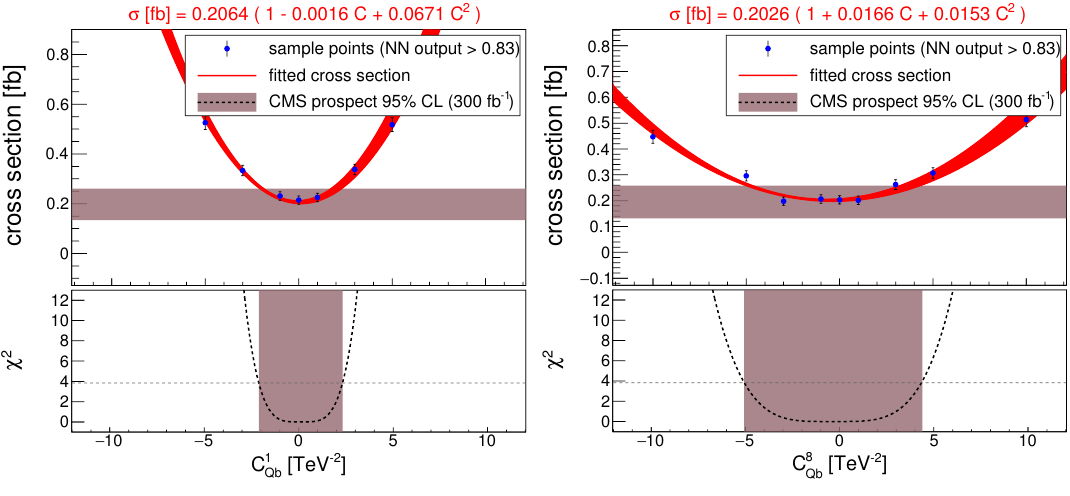
(left) and C 8 (right) after requiring the network output to Qb Qb